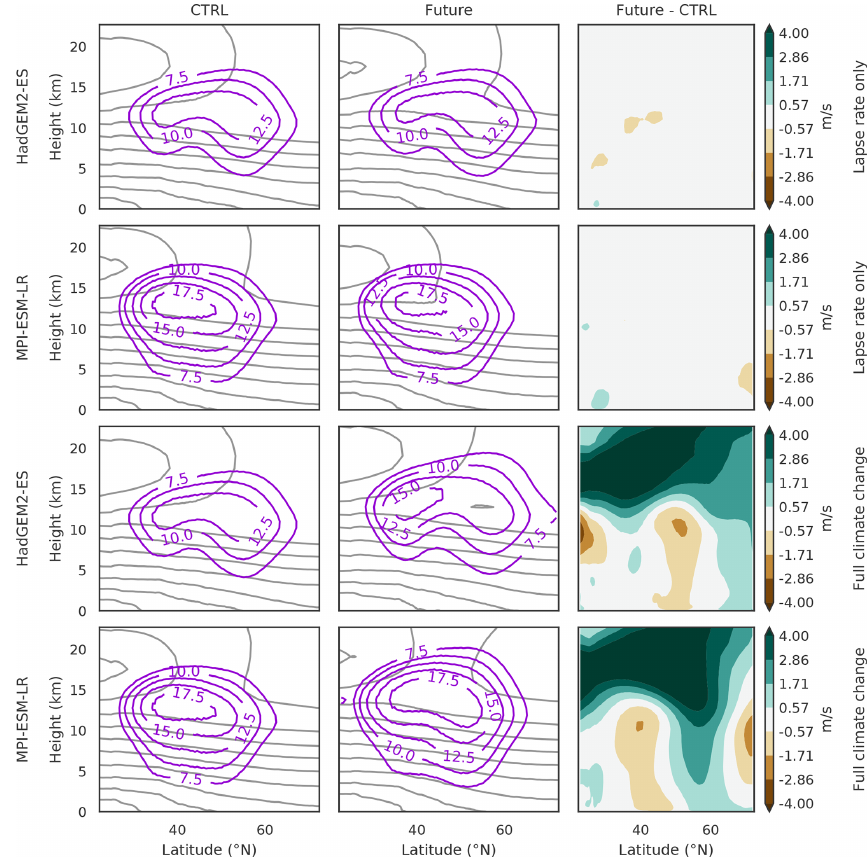
Figure A1. Changes in the mean summer zonal winds in idealized simulations forced by thermodynamics and lapse-rate changes (named TDLR) compared to fully transient climate simulations (named FCC). The first and third row show CCLM4.8 simulations over Europe with climate changes derived from HadGEM2-ES. The second and fourth row show CCLM4.8 simulations based on MPI-ESM-LR. The upper two rows show simulations that have been forced with domain-mean lapse-rate changes and SSTs only (TDLR). The lower two rows show the corresponding transient climate simulations (FCC). (Left column) Meridional cross section of isotherms (gray contours every 10K) and zonal wind (purple contours in ms − 1 ) in the historical simulation (1971–2000). (Middle column) Same as the left column but for the future climate state (2070–2099). (Right column) Difference in zonal wind between the historical and future